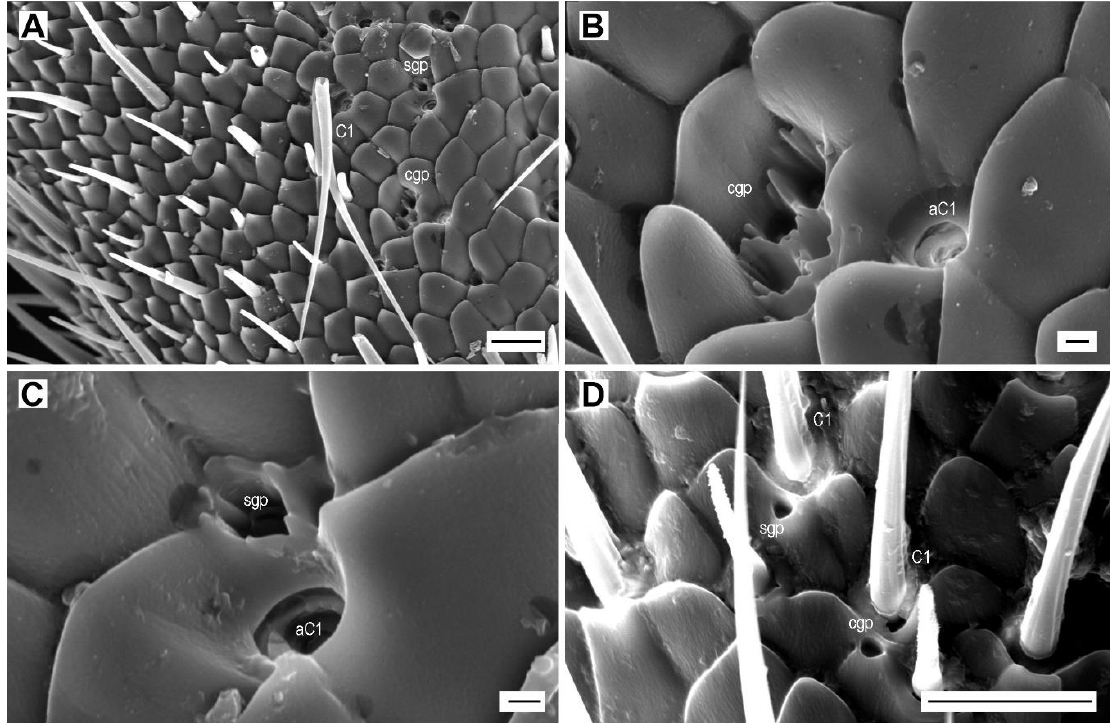
Figure 11. Glandular pores. ( A ) A. pilosellus , male, location of a single glandular pore (sgp) and a cluster of glandular pores (cgp), and sensillum chaeticum C1; ( B ) cluster of glandular pores near alveolus of sensillum C1 (aC1); ( C ) single glandular pore near alveolus of sensillum C1; ( D ) A. medvedevi , male, glandular pores near bases of sensilla chaetica C1. Scale bars = ( A,D ): 10 μm; ( B,C ): 1 μm.